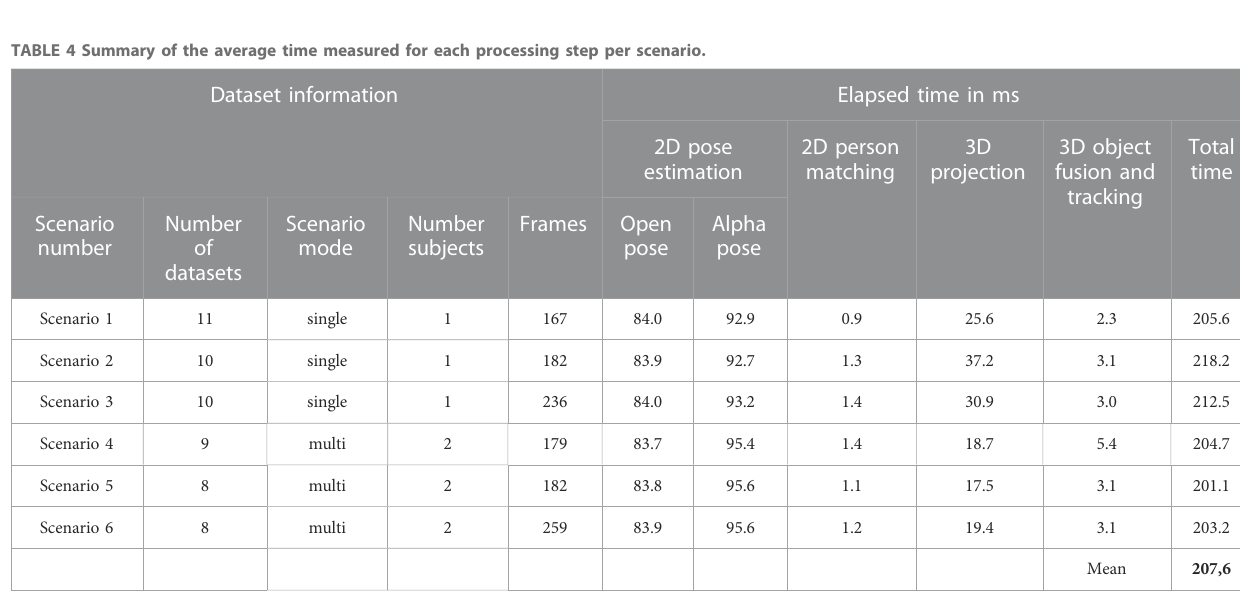
Bold values are the average time over all scenarios.